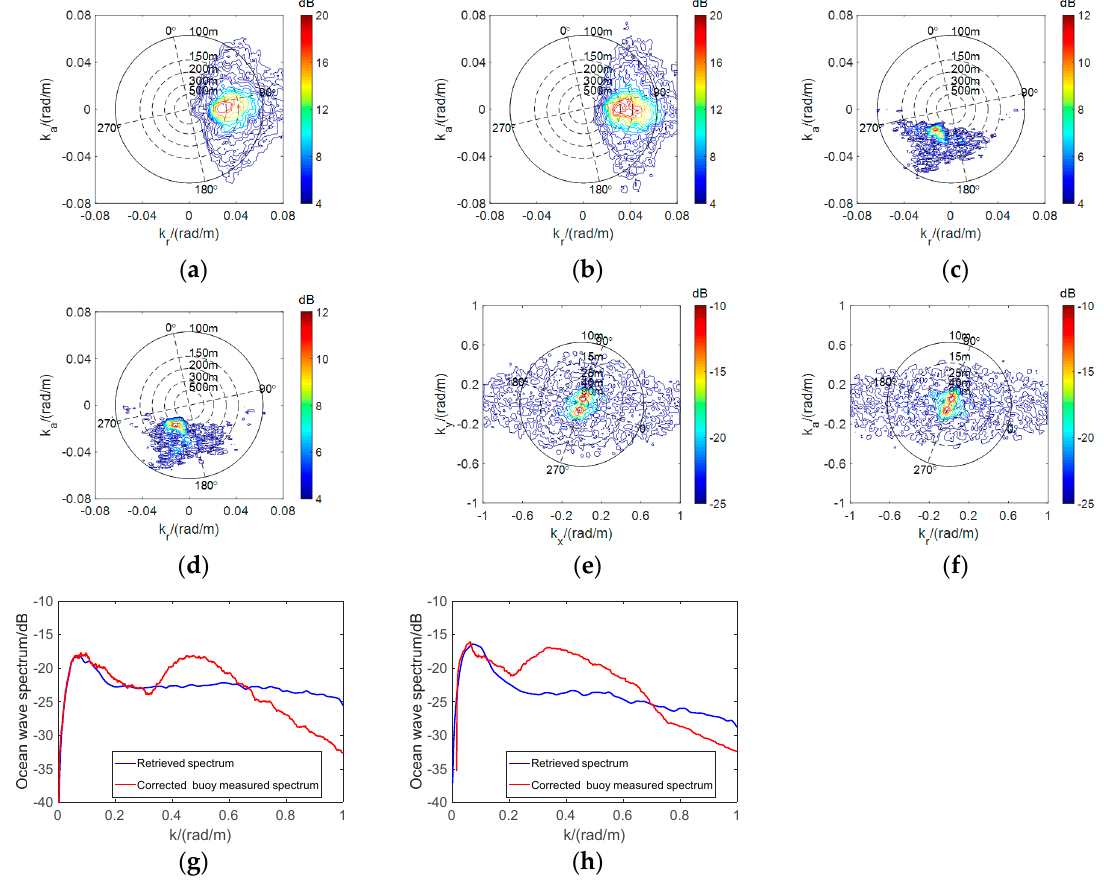
Figure 10. The spectra of the sea surface profiles: A 1 ( a ); A 2 ( b ); A 3 ( c ); A 4 ( d ); M920 ( e ); M3120 ( f ); ( g , h ) one-dimensional spectra retrieved and measured, and the blue lines are the one-dimensional spectra of the sea surface profile retrieved by using the airborne hybrid InSAR system and the red line is the one-dimensional ocean wave spectra measured by the GNSS buoy corrected by low-pass filter.